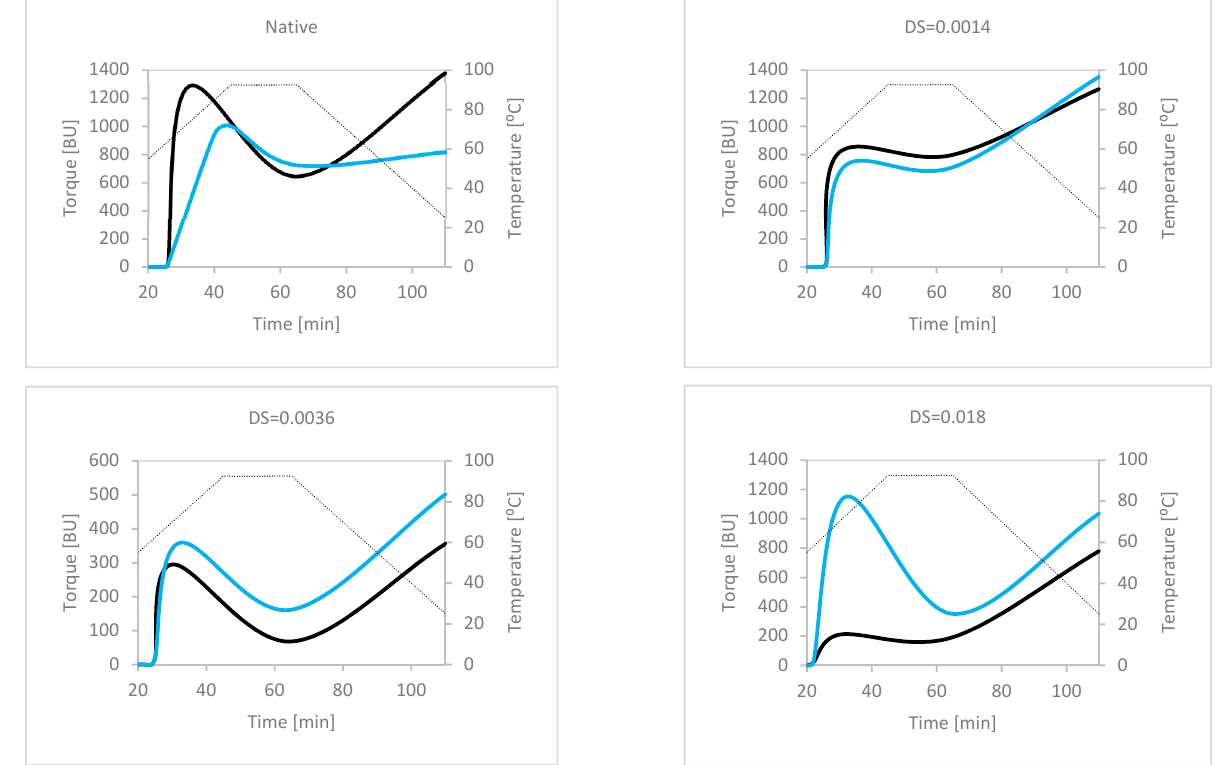
Figure 2. Pasting characteristics of plain (black lines) and fortified (blue lines) native and oxidised starches. Curves were recorded applying different concentrations of starch suspensions: native 5%; DS = 0.0014—5%; DS = 0.0036—8%; and DS = 0.018—20%.